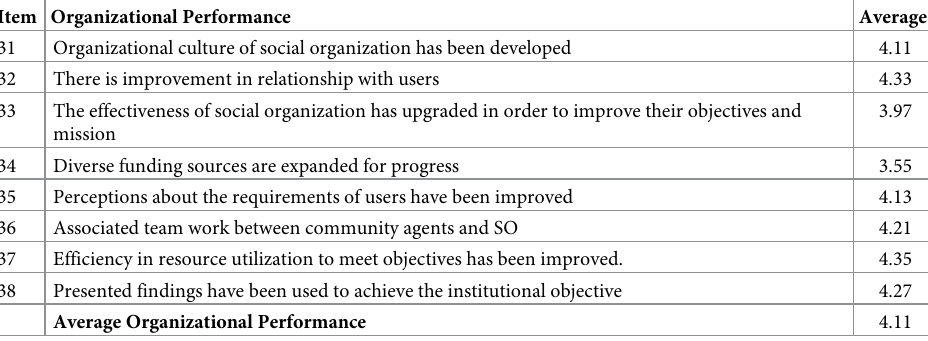
Table 3. Average percentage in the items of organizational performance.